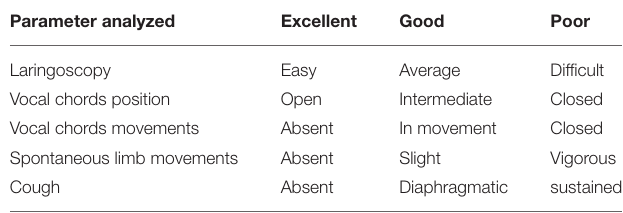
TABLE 1 | Parameters and classification of the quality of intubation. Parameter